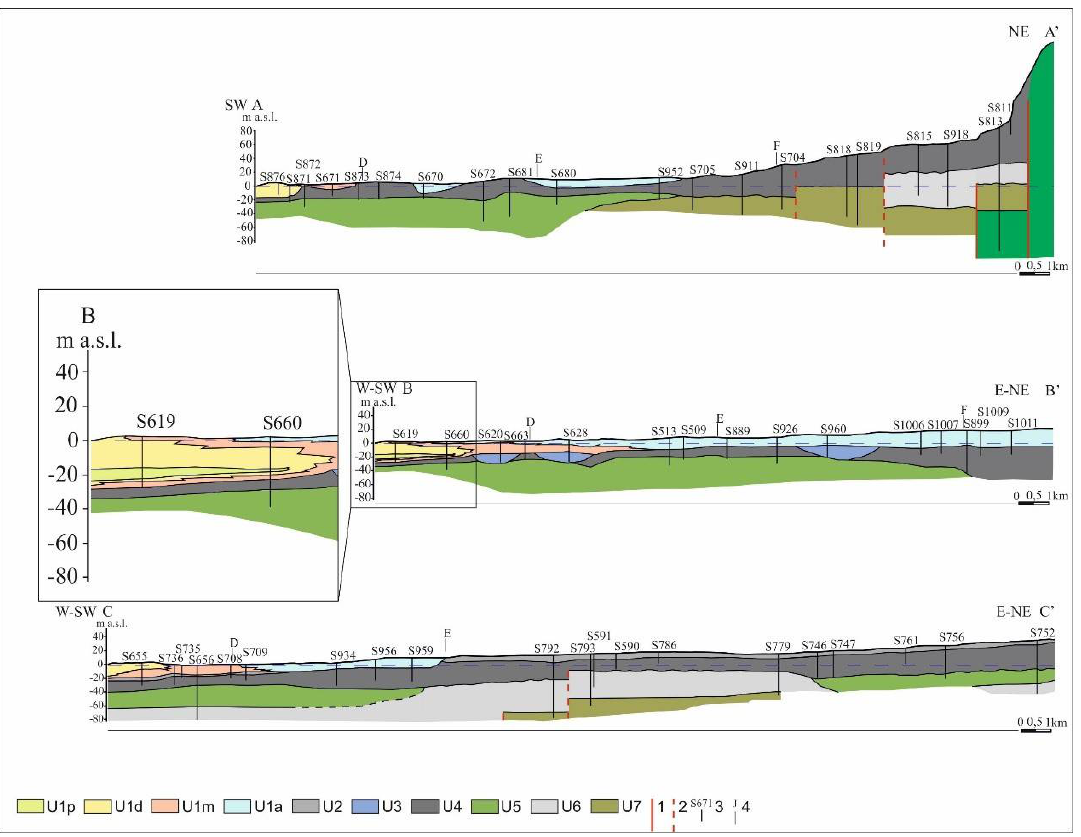
Figure 3. A–A’, B–B’, and C–C’ geological cross-sections. U1p: pro-delta deposits; U1d: